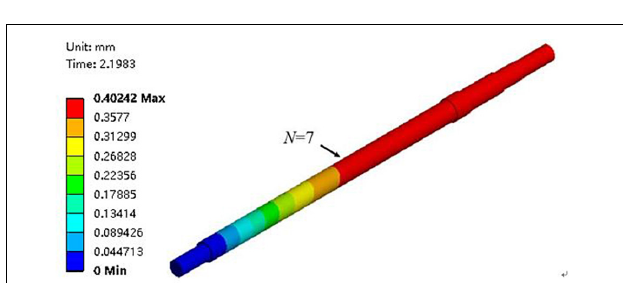
FIGURE 8 | Distribution of deformation of pump shaft t = 2.2 s.